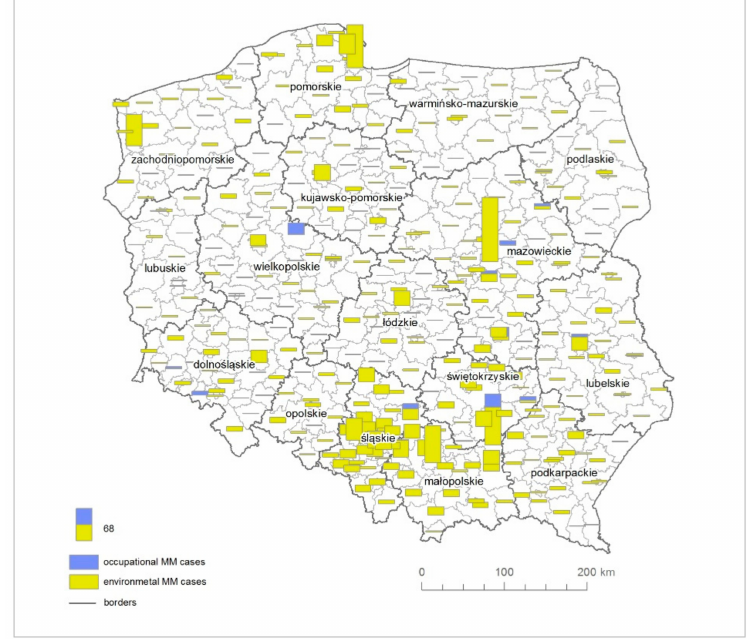
Figure 2. The absolute number of malignant mesothelioma (MM) cases due to the environmental and occupational asbestos exposure.